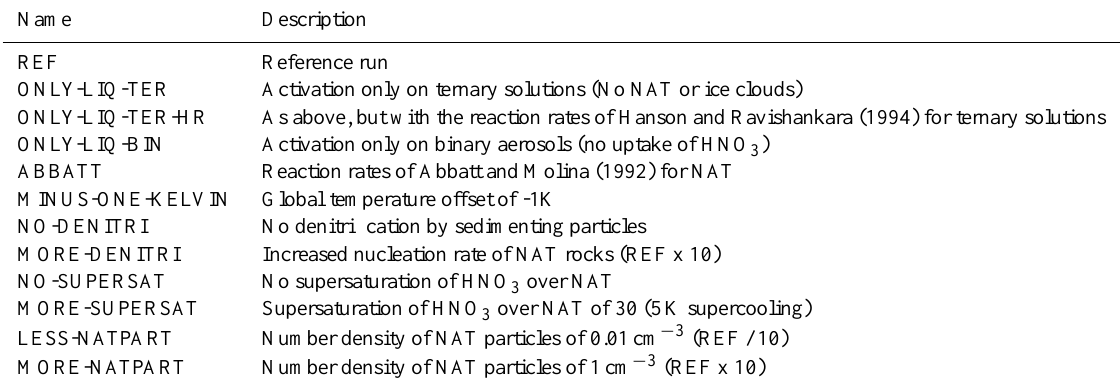
Table 3. Sensitivity runs. Names of the runs and changes with respect to the reference